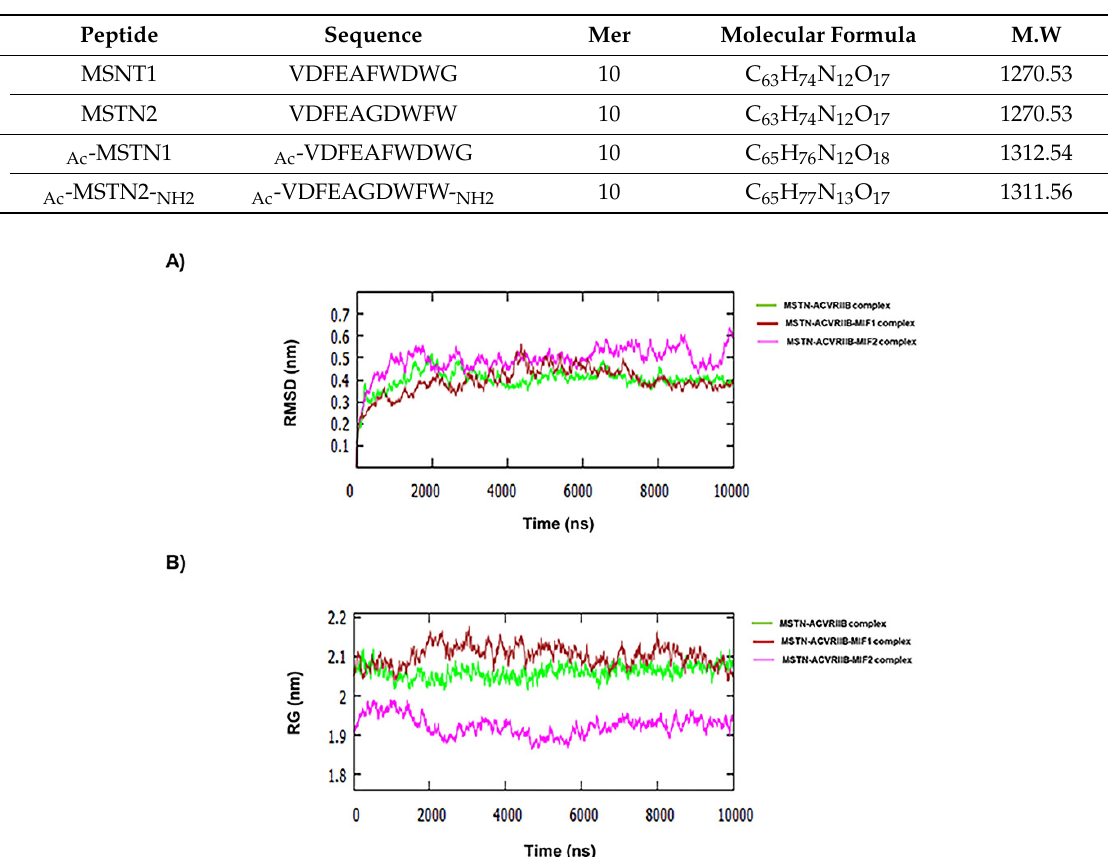
Table 1. List of the MSTN peptides examined. The table shows the peptide sequences, sizes, molecular formulae, and molecular weights of non-modified and modified (by acetylation and/or amidation) peptides.